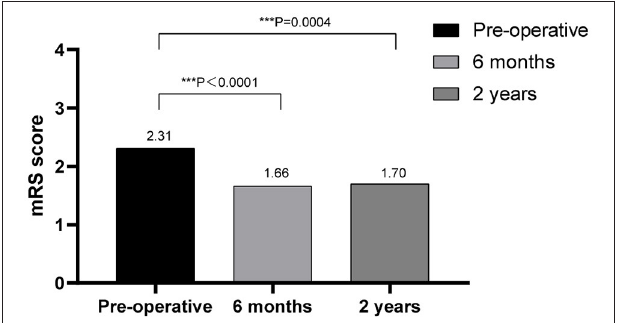
FIGURE 1 | Outcomes of VP-shunt after 6 months and 2 years, comparing preoperative and postoperative mRS scores, showing significant improvement at both times. *** p <